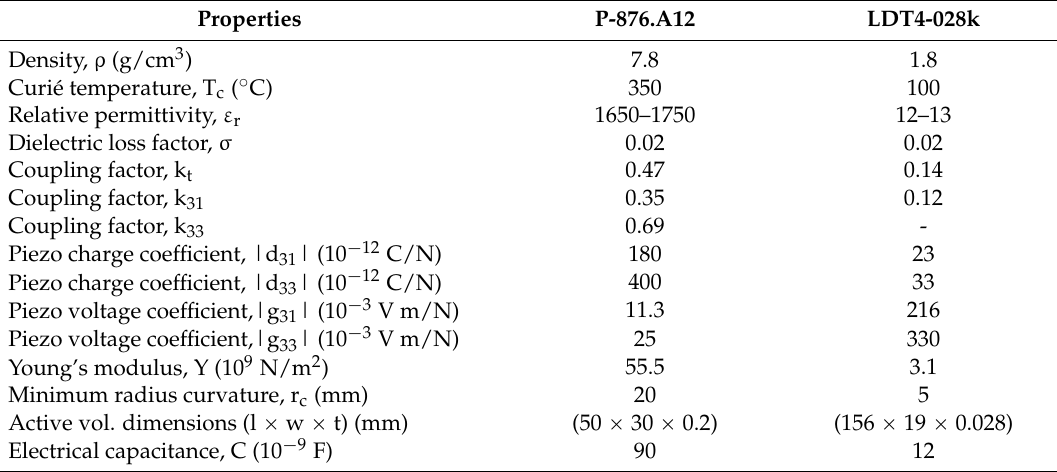
Table 1. Properties of the P-876.A12 and LDT4-028k